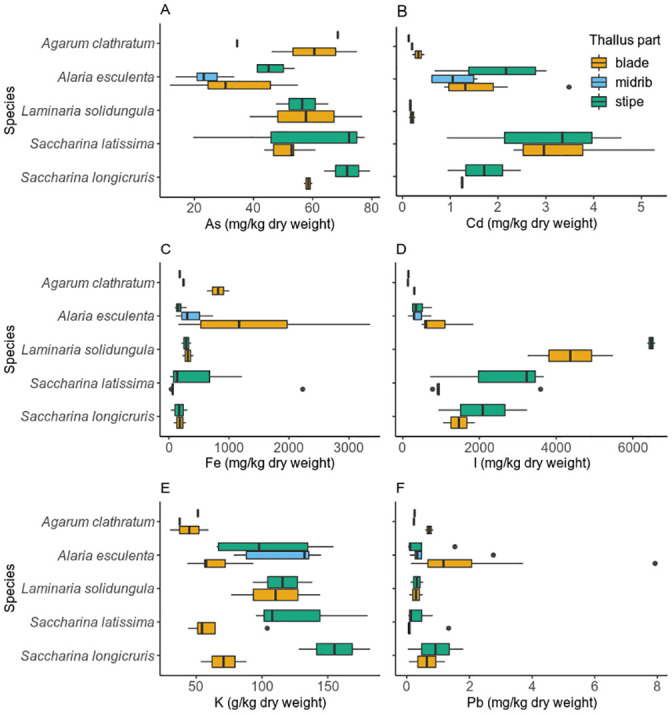
Concentrations of elements (As, Cd, I, Fe, K and Pb) in different thallus parts of Greenland seaweeds for A. clathratum, A. esculenta, L. solidungula, S. latissima and S. longicruris.The lower and upper hinges of the box represent the first and third quartile, around the median; the whiskers extend no further from the hinge than 1.5 * inter-quartile range. Outliers beyond the whiskers are shown as circles.